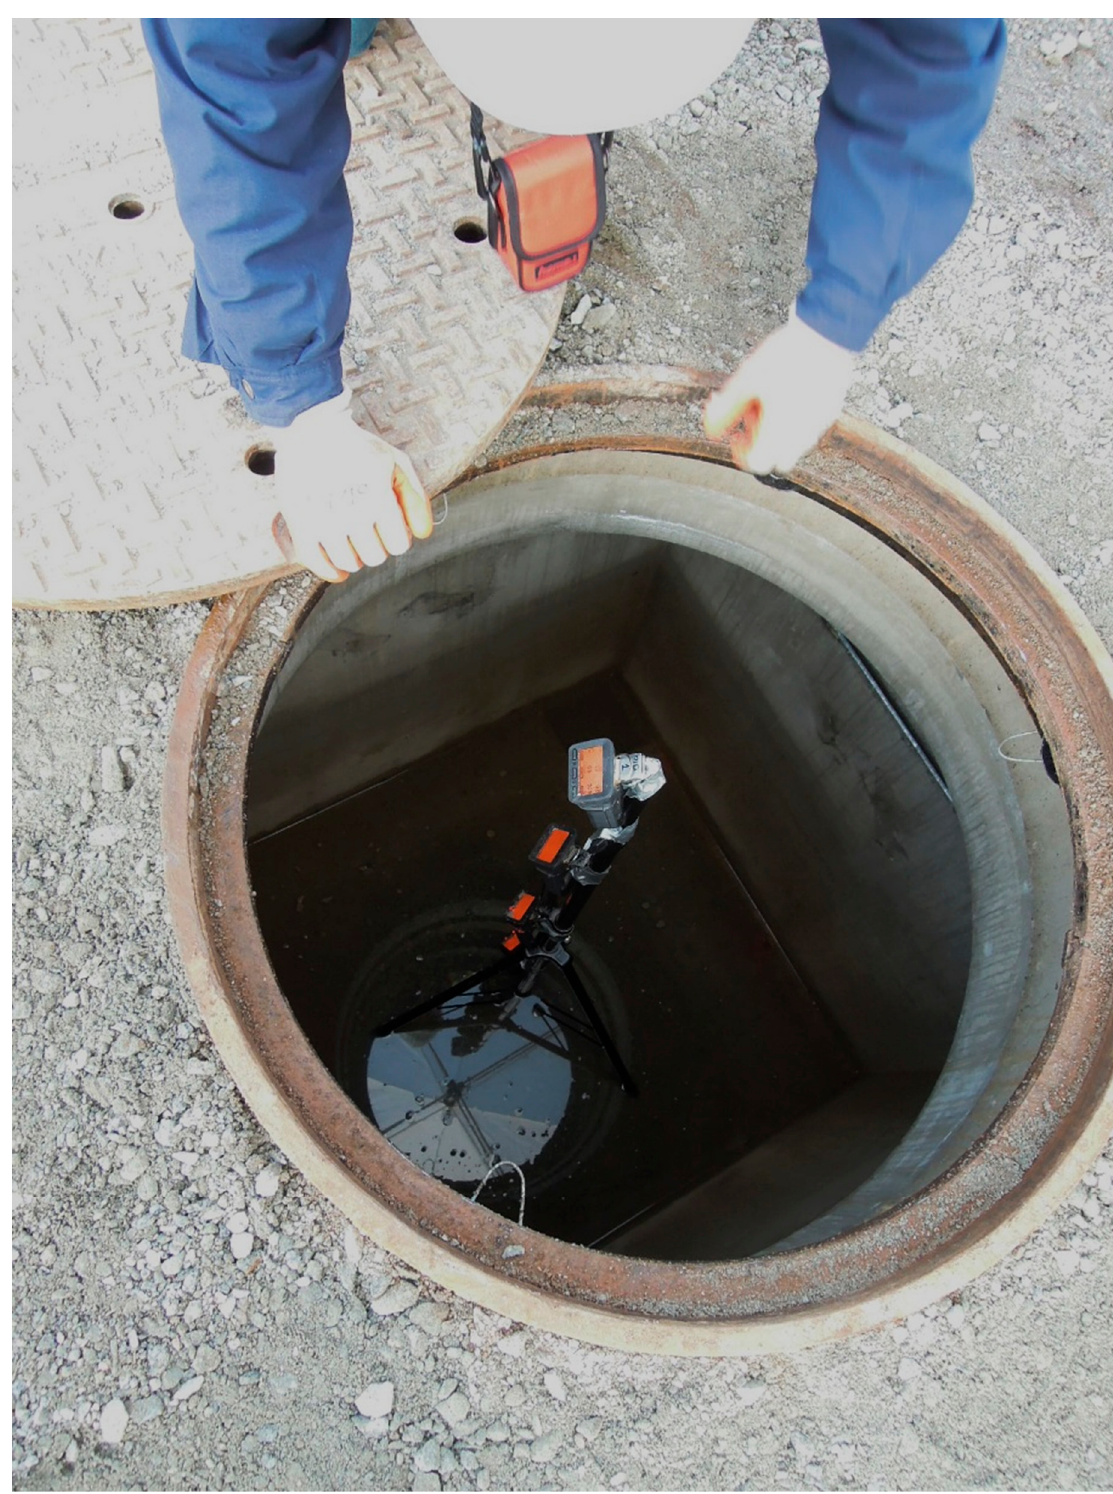
Figure 2. Interior of the structure showing the instruments in alarm on the stand immediately following insertion, just prior to closure of the manhole cover at the beginning of the period of measurement. Series 1 to Series 4 reflected the position of the instruments on the stand at 152 cm (60 in), 114 cm (45 in), 76 cm (30 in), and 38 cm (15 in) above the bottom, respectively.